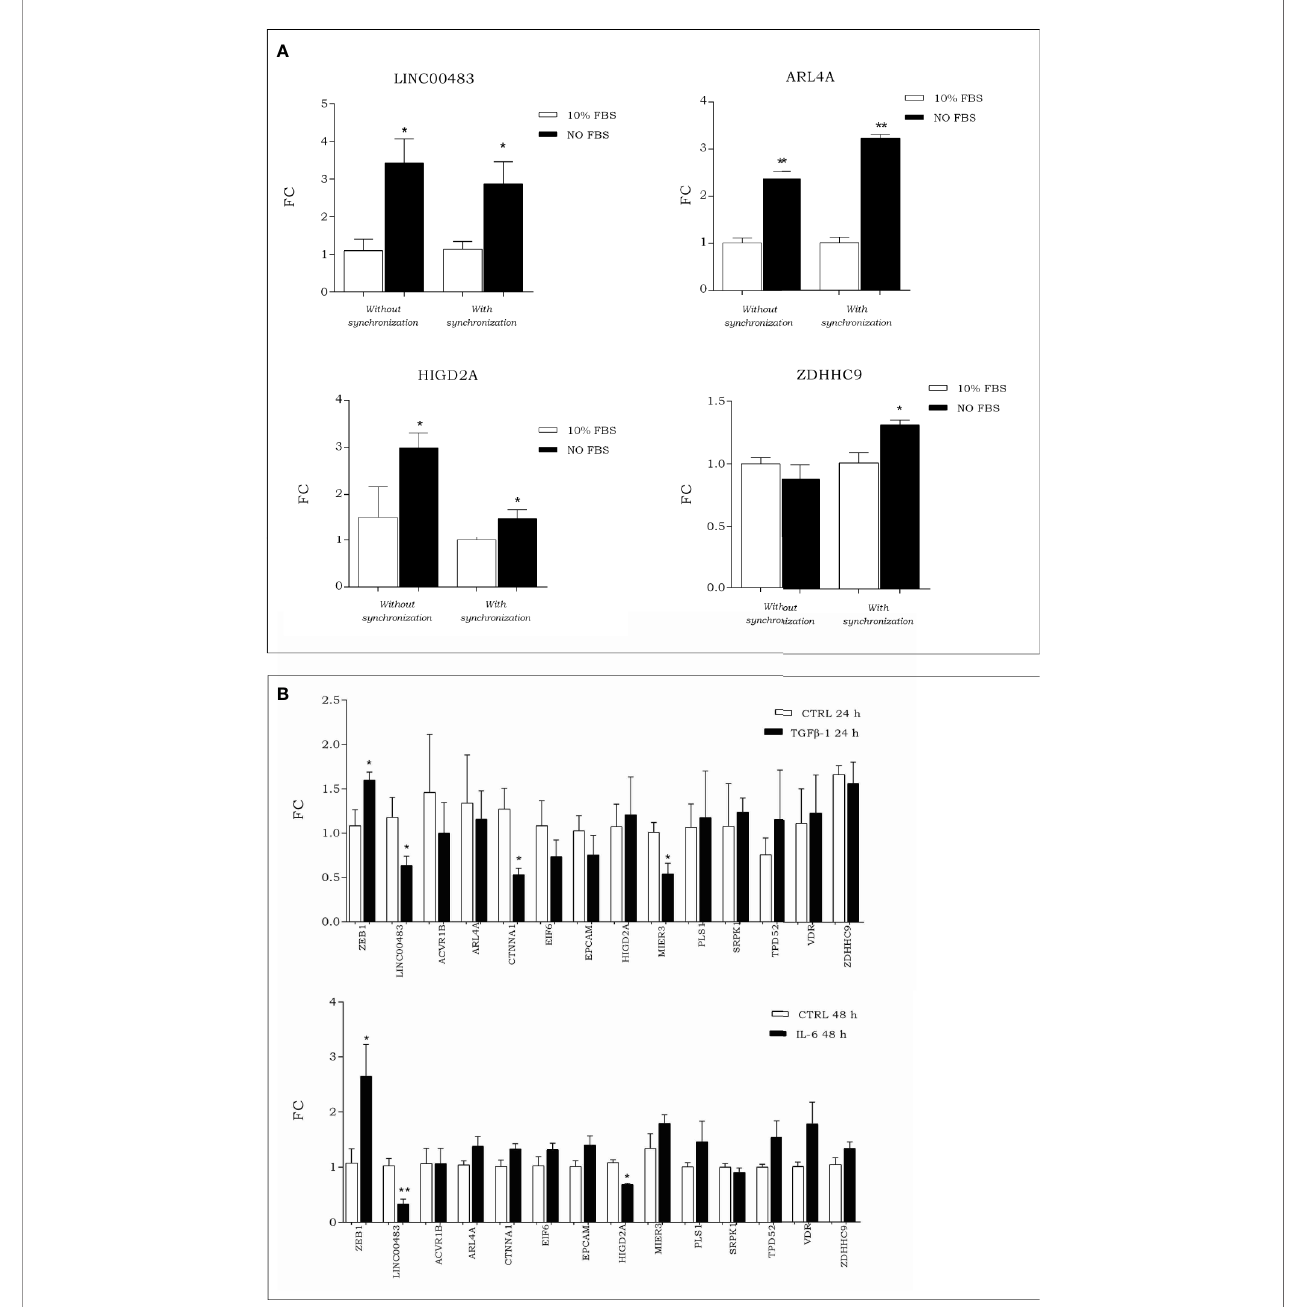
FIGURE 8 | (A) Expression of LINC00483 and messenger RNAs (mRNAs) associated with its molecular axes after 24 h serum starvation, with and without cell synchronization. To make this panel more readable, we reported just signi fi cant data. The complete panel of histograms is reported in Figure S2 . (B) Expression of EMT marker ZEB1, LINC00483 and mRNAs potentially involved in the LINC00483 axes after TGF b -1 and Il-6. *p-value ≤ 0.05; **p-value ≤